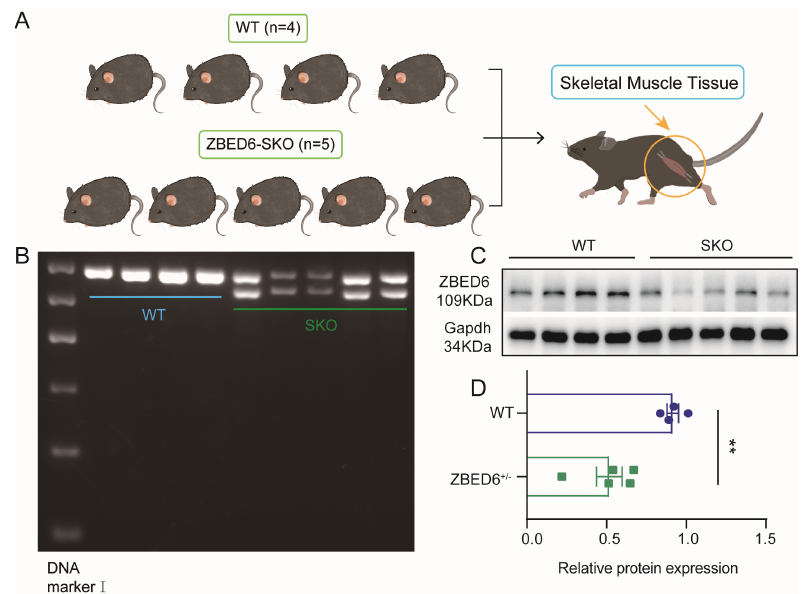
Figure 1. Schematic overview of the production of mice in this study. ( A ) Skeletal muscle tissues were weighed and collected from WT and Zbed6 +/ − mice. ( B ) Genotyping of the different genotype mice was identified by polymerase chain reaction (PCR). The 596 bp band represents the WT mice, and the 561 bp band represents the Zbed6 +/ − . ( C , D ) Western blot analysis of ZBED6 in skeletal muscle from Zbed6 +/ − mice and WT mice. The results are expressed by the means ± SEMs. WT represents wild-type mice, and SKO represents Zbed6 +/ − mice. ** p < 0.01, Student’s t-test. Points in different colors represent actual data of